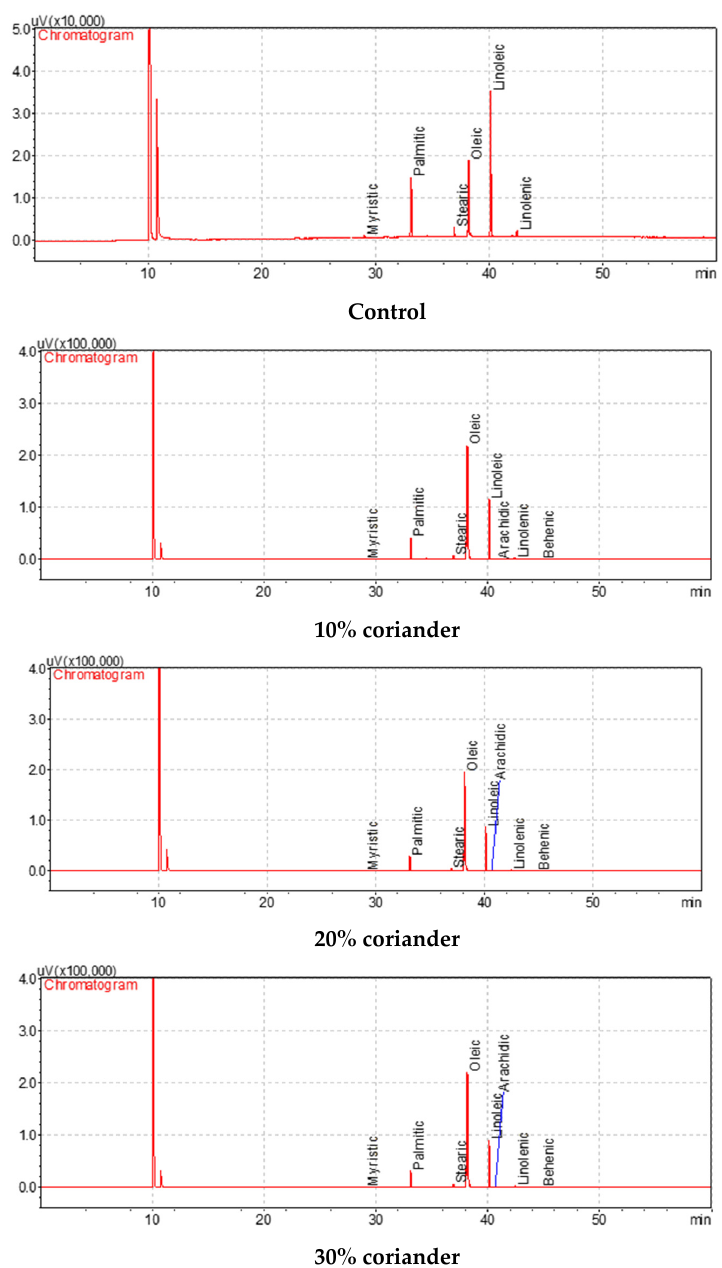
Figure 2. Fatty acid chromatograms of the oils extracted from bread samples enriched with coriander seed powder.